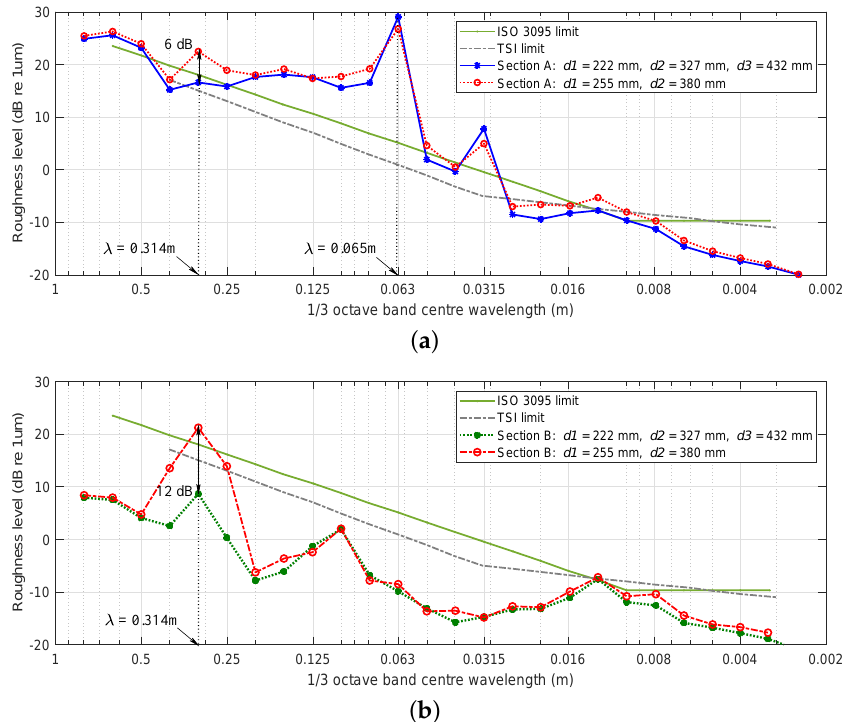
Figure 10. Spectral analysis of railhead roughness in tunnel “Y” track; ( a ) Corrugated rail section A, ( b ) Normal worn rail section B.